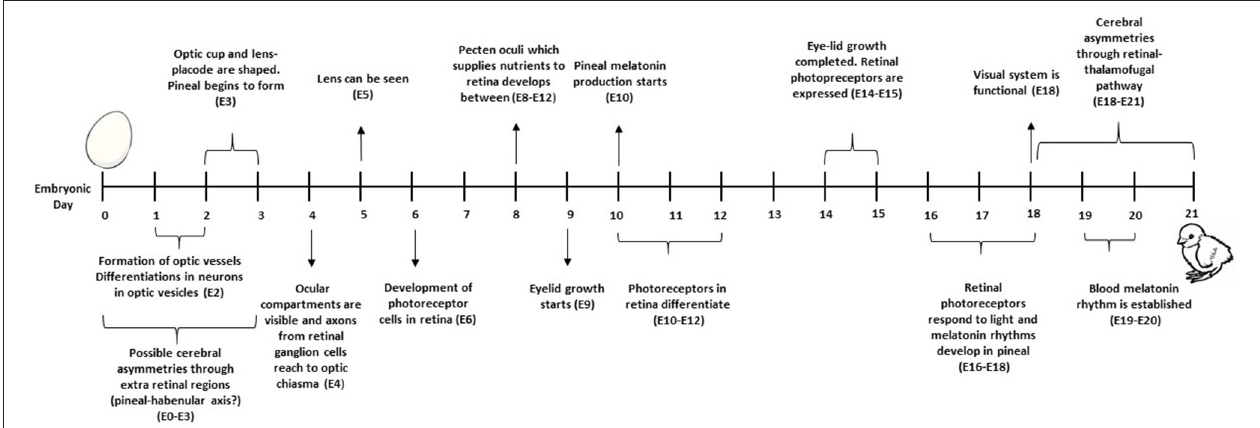
FIGURE 5 | Timeline for development of the visual